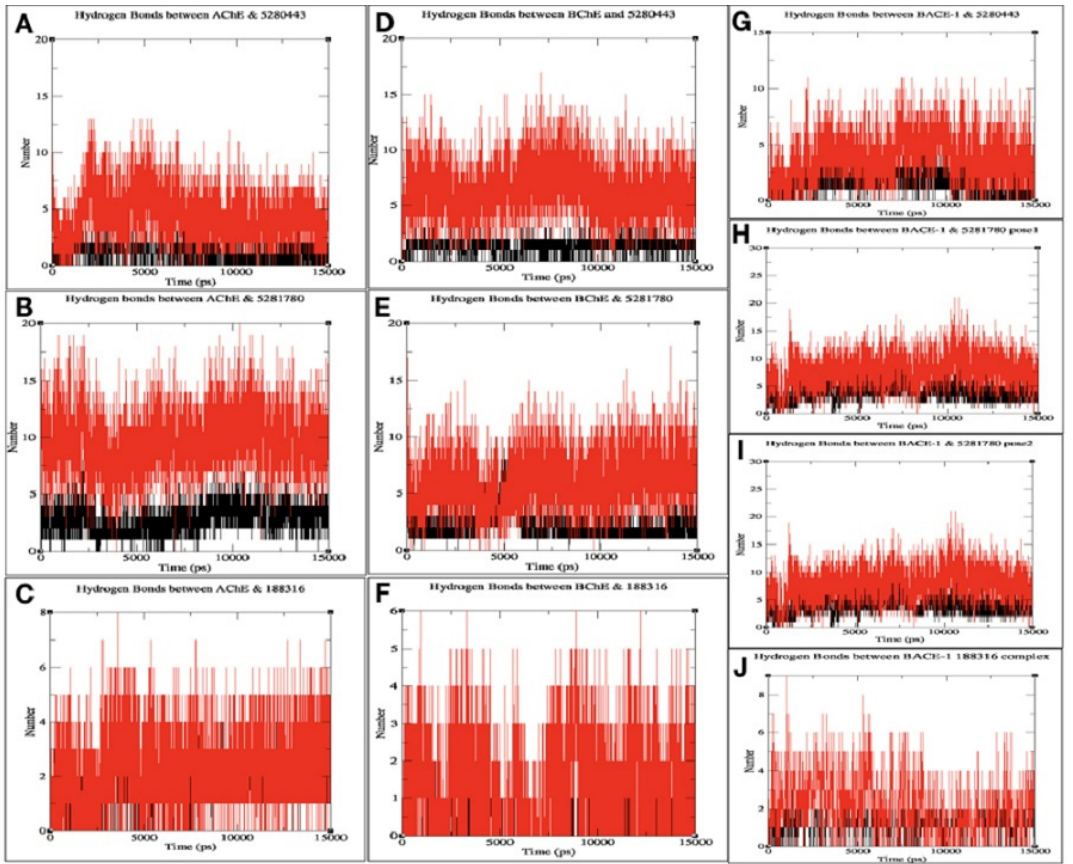
Figure 5. Number of H bonds between the protein–ligand complexes of ( A ) AChE and 5280443 , ( B ) AChE and 5281780 , ( C ) AChE and 188316 , ( D ) BChE and 5280443 , ( E ) BChE and 5281780 , ( F ) BChE and 188316 , ( G ) BACE-1 and 5280443 , ( H ) BACE-1 and 5281780 (pose 1) ( I ) BACE-1 and 5281780 (pose 2), and ( J ) BACE-1 and 188316 .